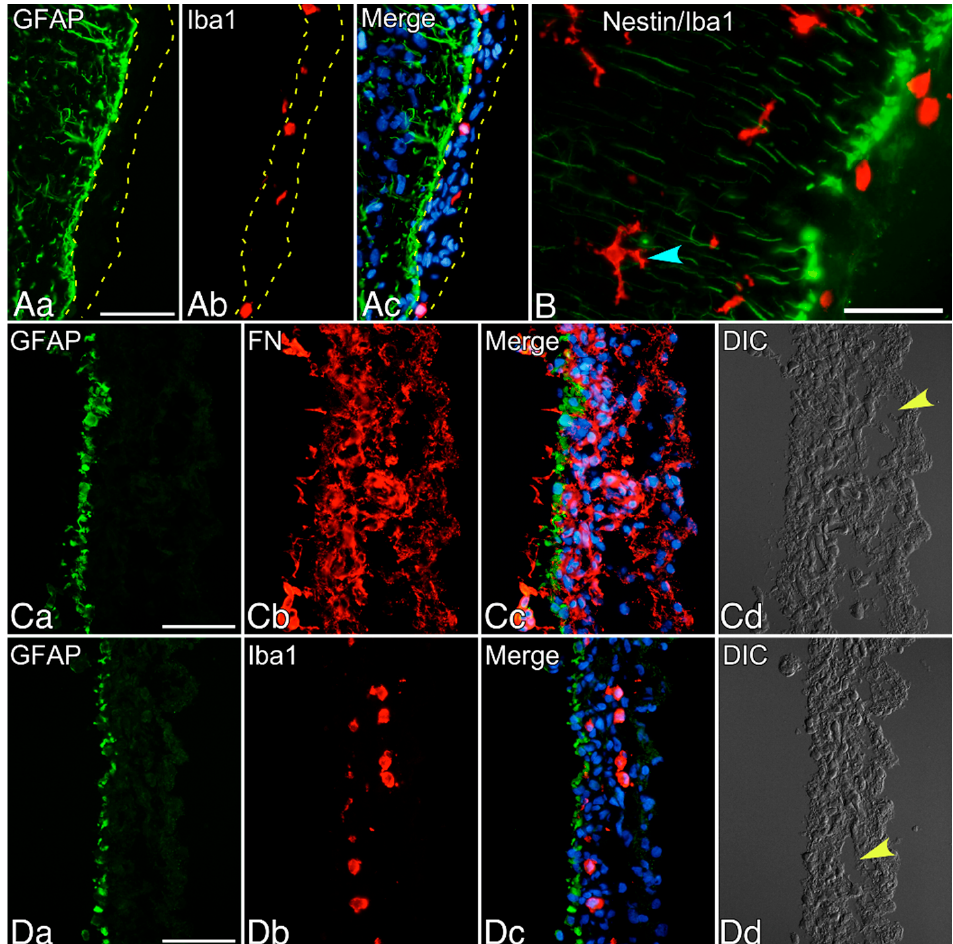
Figure 1. Leptomeninges enveloping the surface of the neonatal rat cerebral cortex. ( A , B ) show leptomeninges in Scheme 1. macrophages (red). Nuclei were stained blue by Hoechst 33258. ( B ) GFAP + cells over the surface of the brain parenchyma expressed nestin (green), and Iba1 + ramified microglia (red, denoted by a blue arrowhead) were present in the parenchyma. ( C , D ) show sections of fixed leptomeninges that were peeled off the brain surface. ( C ) The peeled-off leptomeninges contained a GFAP + monolayer (green) located on the brain surface, and fibronectin + cells (FN, red). Nuclei were stained blue by Hoechst 33258. ( D ) Many macrophages (Iba1, red) were present in the peeled-off leptomeninges contained a GFAP + monolayer (green). Nuclei were stained blue by Hoechst 33258. The yellow arrowheads in ( C , D ) denote the subarachnoid space. DIC: differential interference contrast. Scale bars = 50 µ